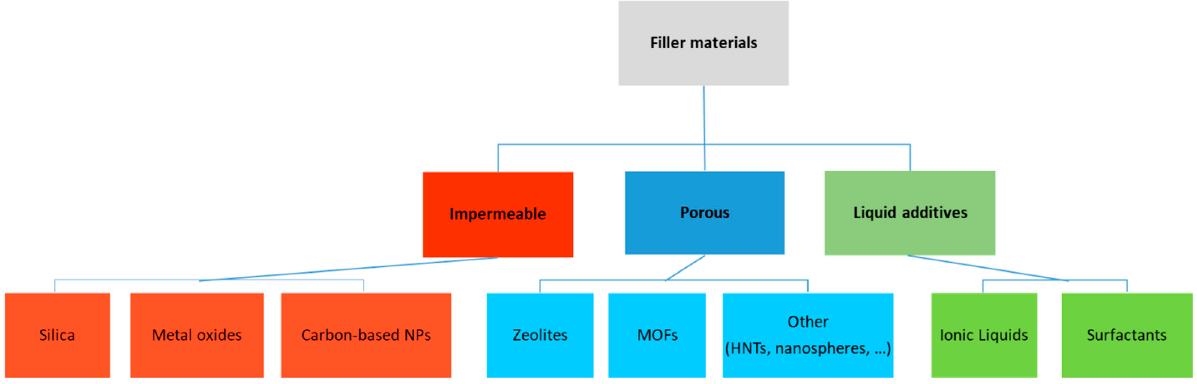
Figure 2. Filler materials adopted for Pebax ‐ based MMMs.